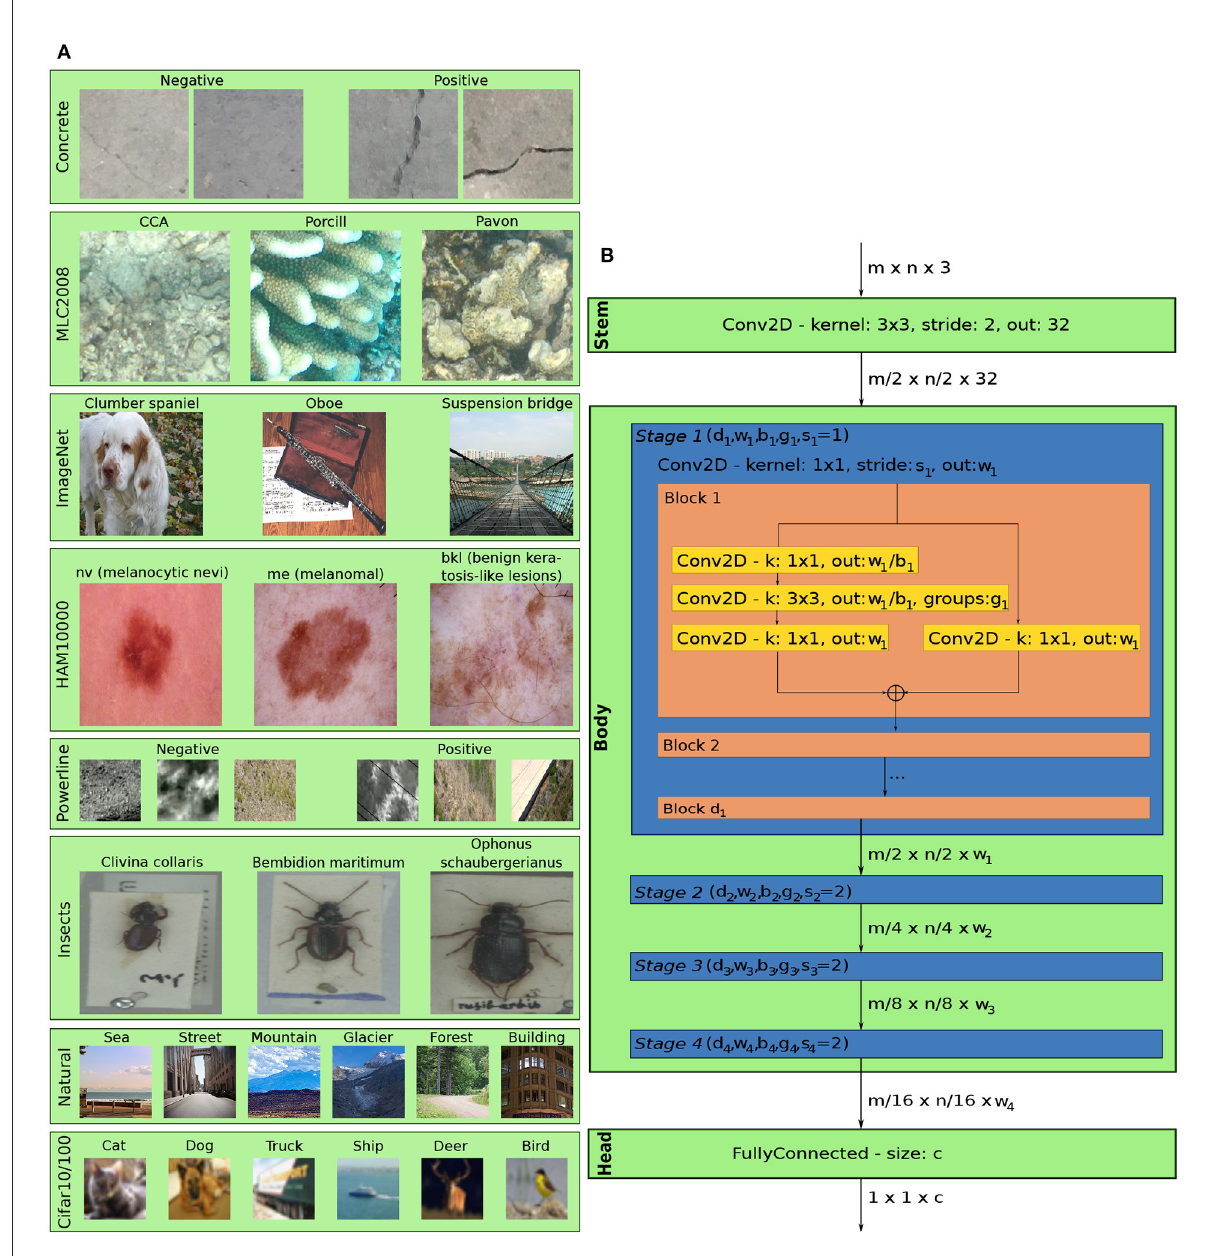
FIGURE2 (A) Example images from each dataset. Images of Cifar10/100 are magnified fourfold, the rest are shown in their original resolution (best viewed by zooming into the digital document). (B) The structure of models in the AnyNetX design space, with a fixed stem and a head, consisting of one fully-connected layer of size c , (where c is the number of classes). Each stage i of the body is parametrised by d i , w i , b i , g i , the strides of the stages are fixed with s 1 = 1 and s i = 2 for the